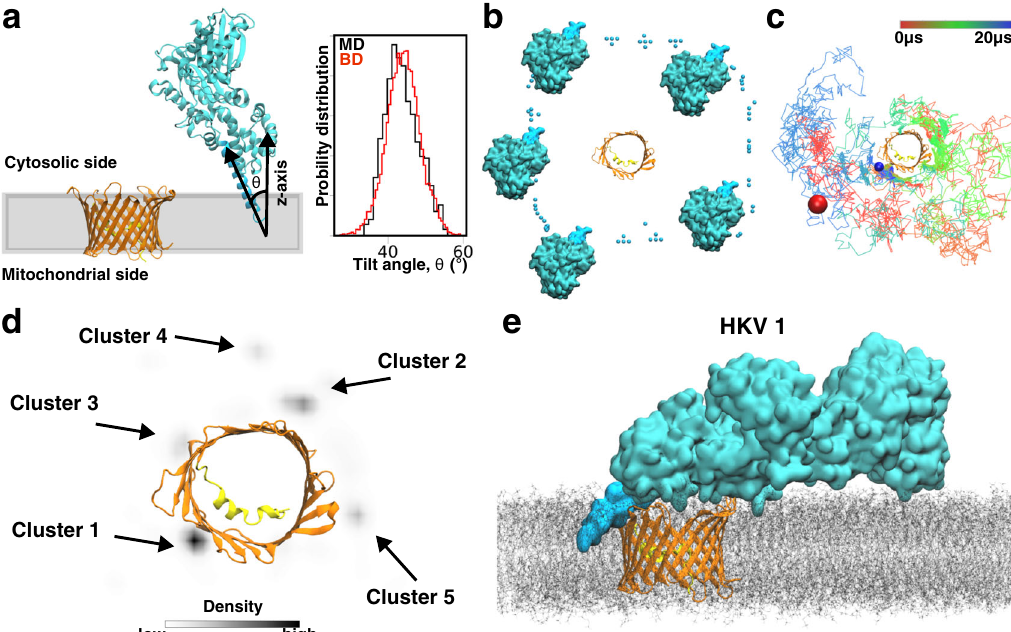
Fig. 3 Binding of membrane-inserted HKII-N to VDAC1 and their complex formation. a Side view of the initial con fi guration in a BD simulation system. During the simulation, restraints along the z -axis (direction normal to the membrane plane represented as the gray box) were applied to the H-anchor, to maintain the positioning and the tilt angle distribution of the H-anchor ( Inset ) in BD simulations close to those observed in full-membrane MD simulations (see SI for more details). For tilt comparison, the distributions obtained from 1.5 μ s of ARBD simulations of HKII-N (in the absence of VDAC1) and the last 100 ns of full-membrane simulation of HKII-N are compared in the inset. VDAC1 is colored in orange with its N-terminal helix in yellow. The coloring scheme of HKII-N is identical to Fig. 1. b Top-down (cytosolic) view showing the initial placements of HKII-N around VDAC1 in independent BD simulations. Only 5 out of 100 HKII-N replicas are shown in full for clarity. The initial positioning of the other 95 replicas is represented by the COM of the H-anchor. c A representative BD simulation trajectory showing the collision and interaction of HKII-N with different locations of the outer rim of VDAC1 and its eventual binding. The colored line tracks the position of the COM of the H-anchor over a 20- μ s BD simulation. The initial and fi nal positions of the H-anchor are shown as red and blue spheres, respectively. d The density map of the COM of H-anchor, calculated using the trajectories from all 100 independent BD replicates. The density map was calculated using the kernel density approximation module implemented in Seaborn 94 . Five distinct density hot spots, each corresponding to a different cluster, are highlighted with black arrows. The clusters are ranked according to their population (Table S1). e A snapshot (at t = 350 ns) of membrane-embedded HKII/VDAC1 complex 1 (HKV1) during the full-membrane MD